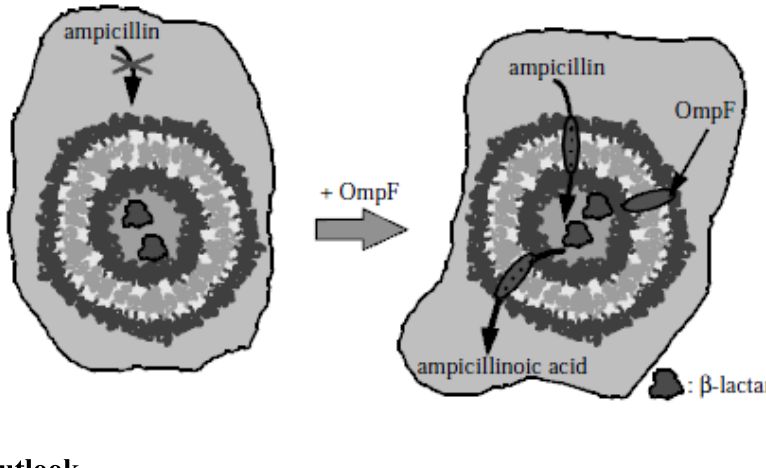
Figure 14. PMOXA-PDMS-PMOXA polymersome with encapsulated β -lactamase. Left side: ampicillin cannot permeate polymersome membrane. Right side: ampicillin and ampicillinoic acid can transfer across the polymersome membrane through OmpF channel. Reprinted with permission from Nardin et al . Copyright (2001) John Wiley & Sons, Inc.